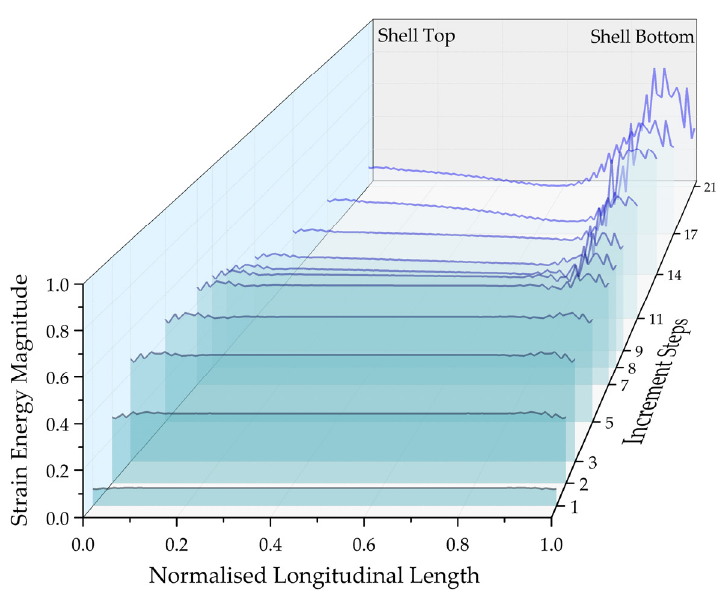
Figure 18. Shell (9 m at 24 mm) strain energy magnitudes along the normalised longitudinal length at typical increment steps, under combined loads.